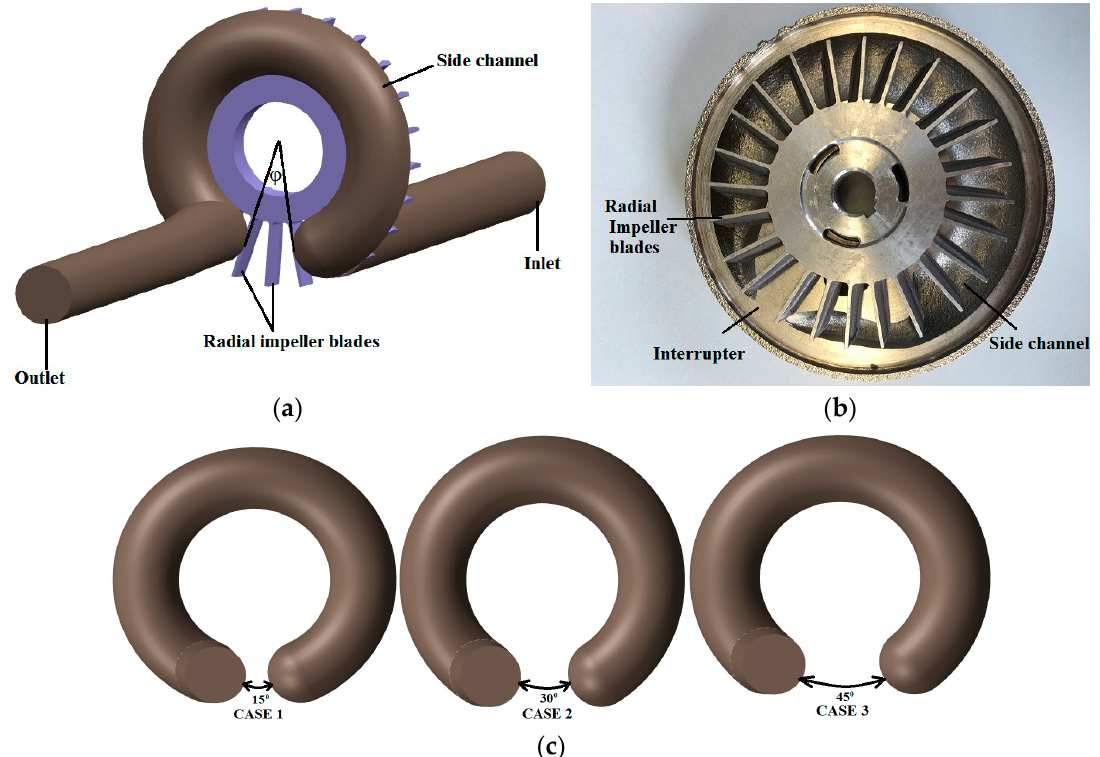
Figure 1. Structure of a single stage model of a side channel pump. ( a ) 3D pump model; ( b ) typical assembly of side channel with radial impeller; ( c ) side channel with different wrapping angles. Table 1. Main parameters of pump model.